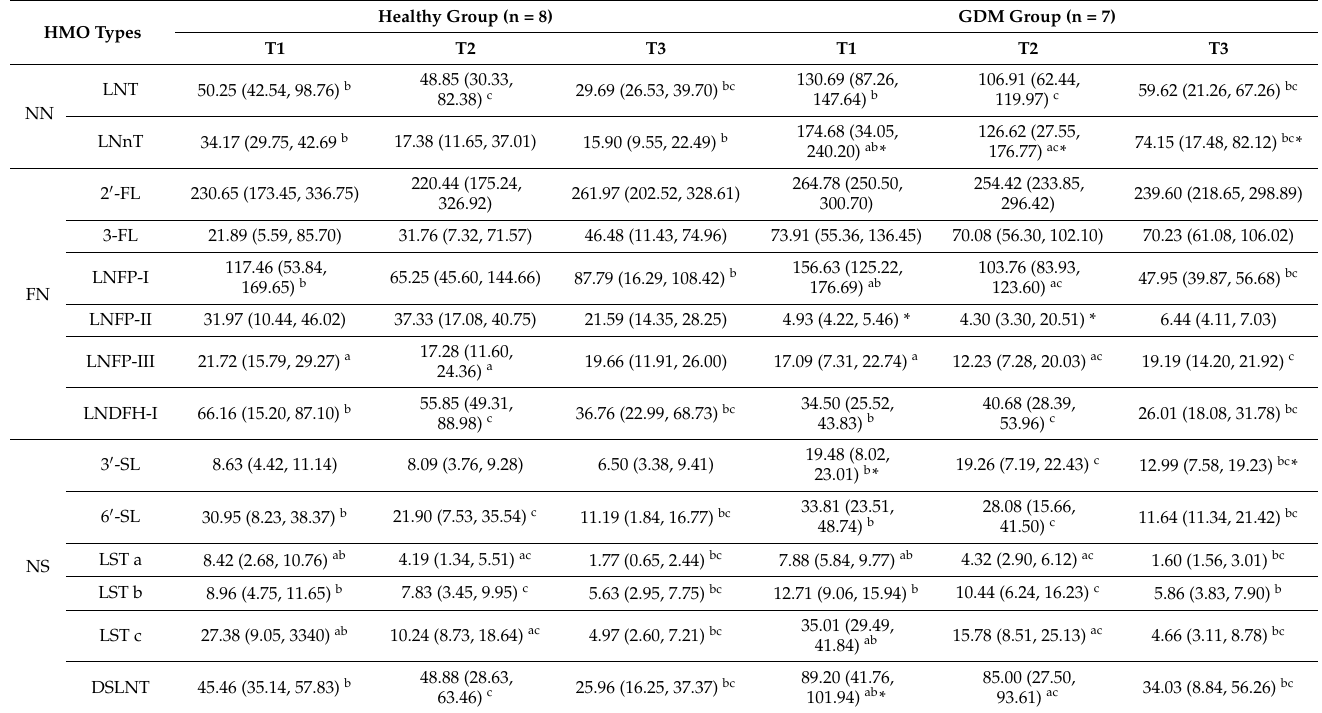
Table 2. Changes in various types of human milk oligosaccharides (HMOs) over time in Se + Le +